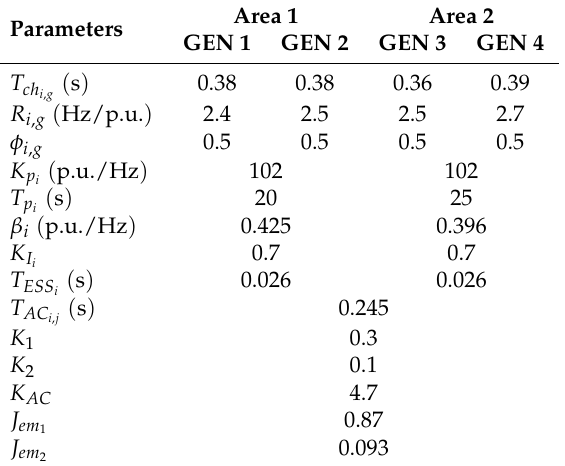
Table 1. Parameters of the two-area system and associated control